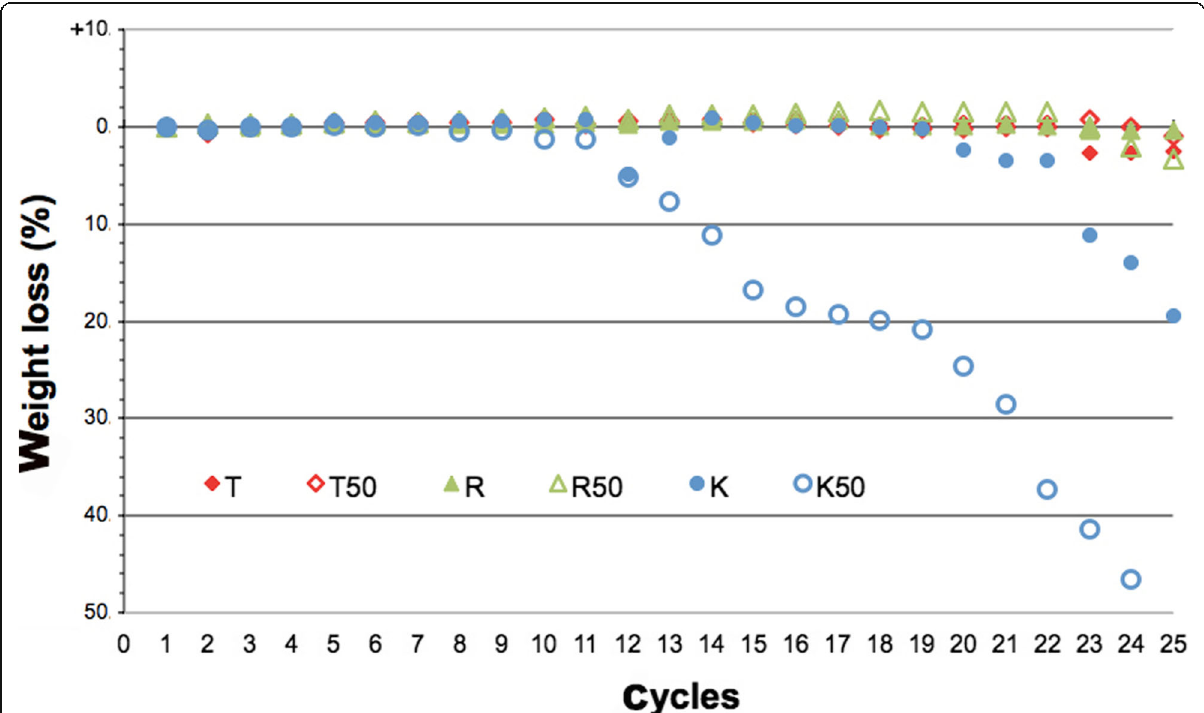
overlap between the symbols at 0.00 line up to 21 cycles)